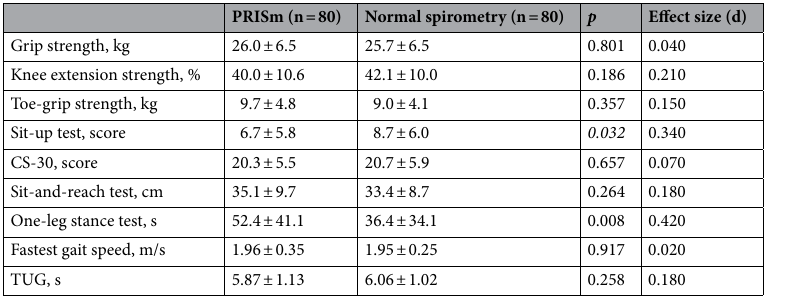
Table 4. Comparison of physical function measurements between the PRISm and normal spirometry groups. CS-30 30-s stand test, PRISm Preserved ratio impaired spirometry, TUG Timed